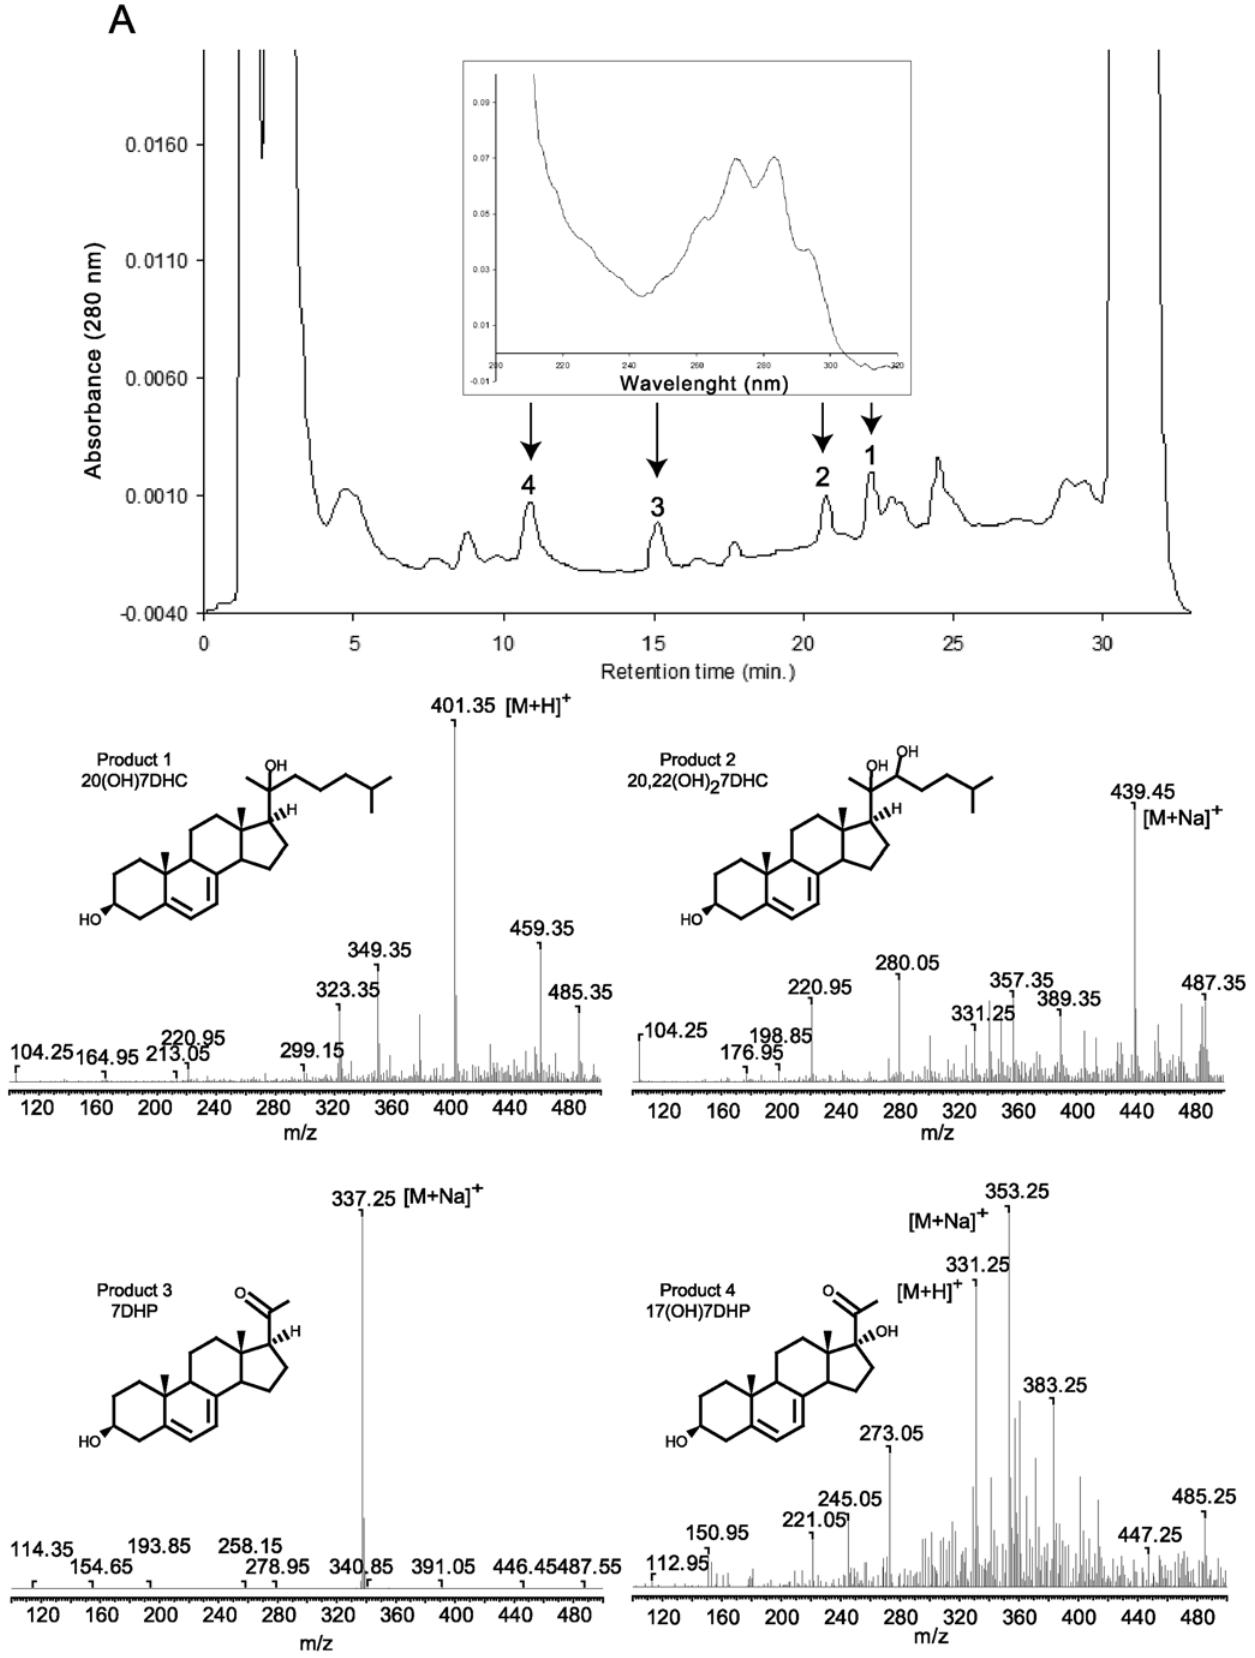
Figure 4. Metabolism of 7DHC by pig adrenal glands. Fragments of pig adrenal glands were incubated with 0.5 mM 7DHC. Steroids were extracted with methylene chloride and subjected to HPLC and UV spectral analyses. The UV spectrum for all peaks is the same (see arrows). The mass spectra of the collected peaks 1–4 were obtained by direct injection into the MS module of the Bruker Esquire-LC/MS Spectrometer. doi:10.1371/journal.pone.0004309.g004 PLoS ONE |